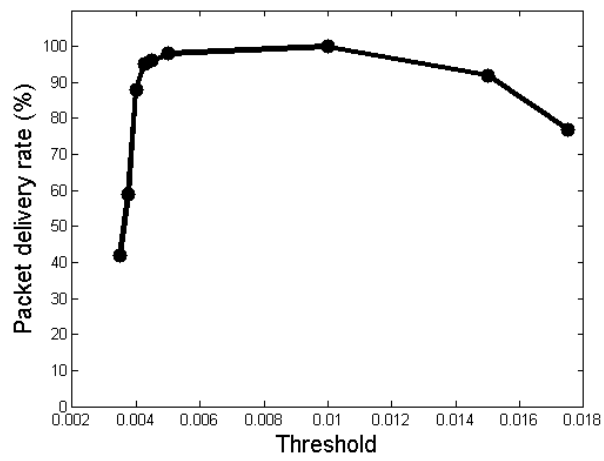
Figure 10. The packet delivery rate as a function of the threshold α on a wooden table. The distance between a transmitter and a receiver was 50